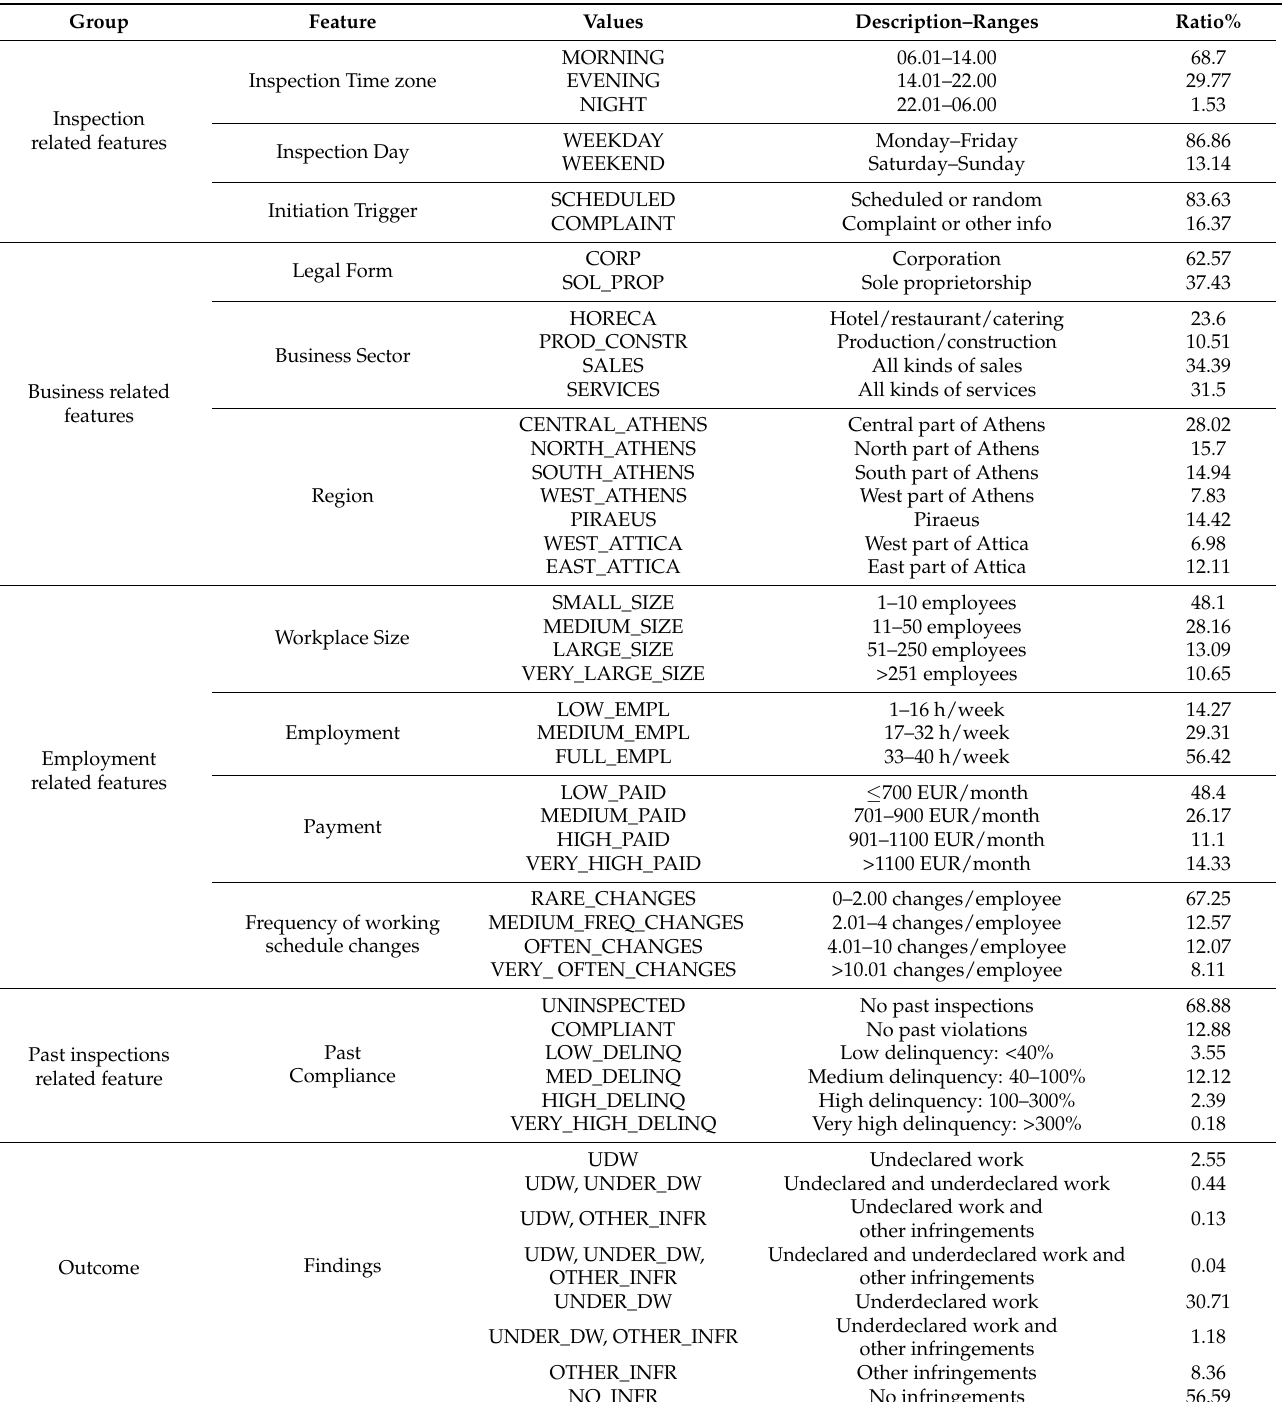
Table 1. Initial dataset: features, set of values per feature, and categorical values ratio in the